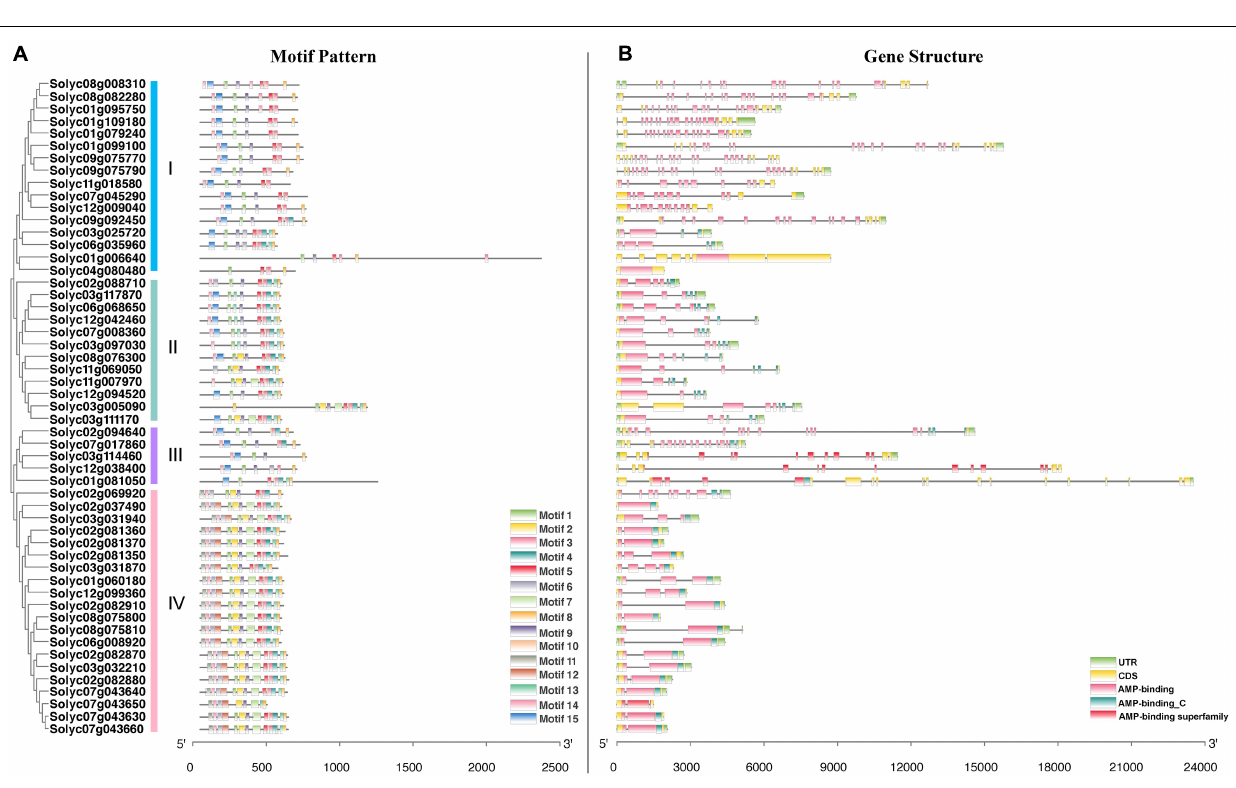
Frontiers in Plant Science |